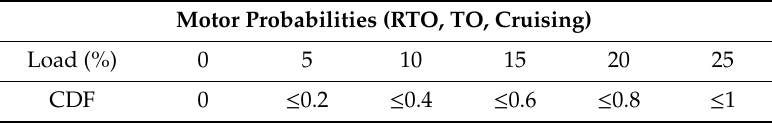
Table 3. Motor CDF